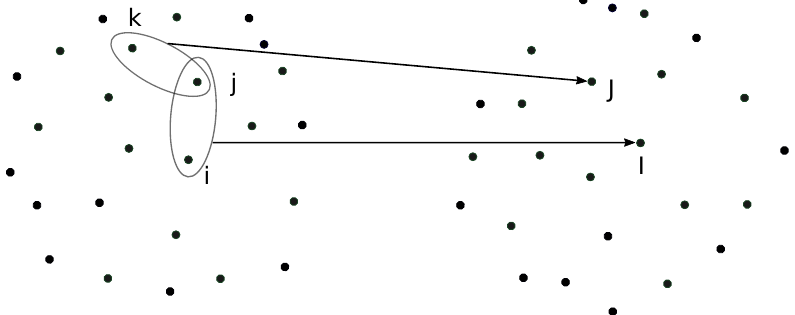
Figure 1 . Each column of the M (cid:2) L matrix represents a point in the set of L sites on the left panel. At each site, one can de(cid:12)ne a local Hilbert space spanned by a column of M scalars. Under SL( L; R ) that acts on the matrix from the right, column vectors are linearly superposed to form a new set of L column vectors. The rotated column vectors de(cid:12)ne a new set of sites and associated local Hilbert spaces shown in the right panel. A choice of local Hilbert spaces into which the total Hilbert space is decomposed is called a